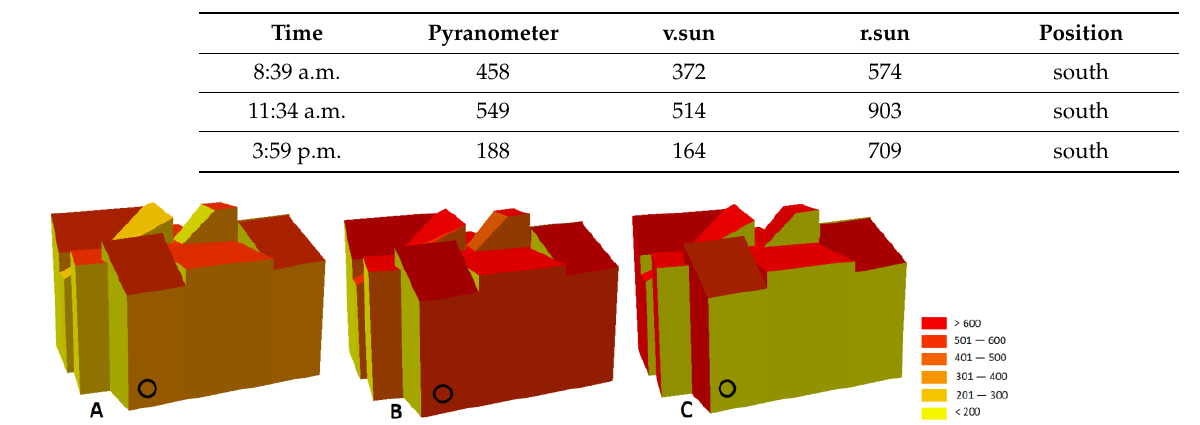
Figure 6. Solar irradiance at the residential house from the v.sun model on 23 June 2021 (W/m 2 ) at ( A ) 8:39 a.m., ( B ) 11:34 a.m., and ( C ) 3:59 p.m. The black circle represents the measurement